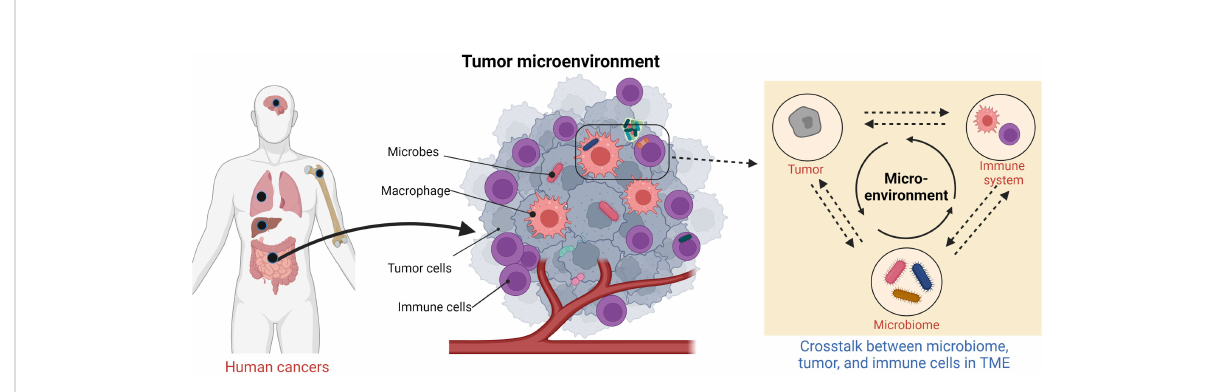
FIGURE 1 Schematic of human tumor microenvironment that contains tumor